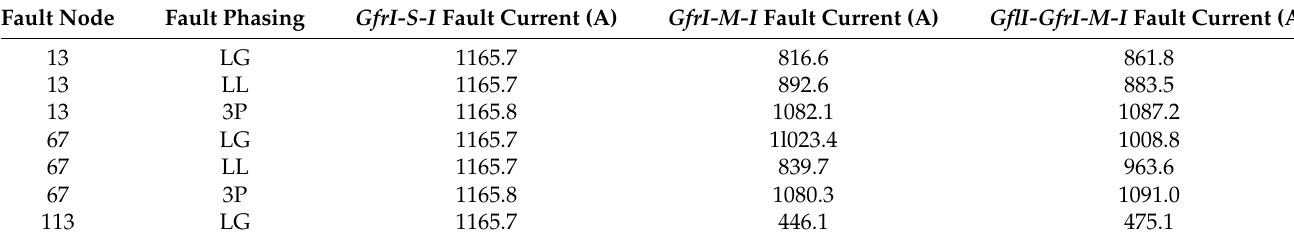
Table 8. Comparison of results for configurations GfrI-S-I, GfrI-M-I, and GflI-GfrI-M-I of the IEEE 123-Node System, and 20 Ω fault